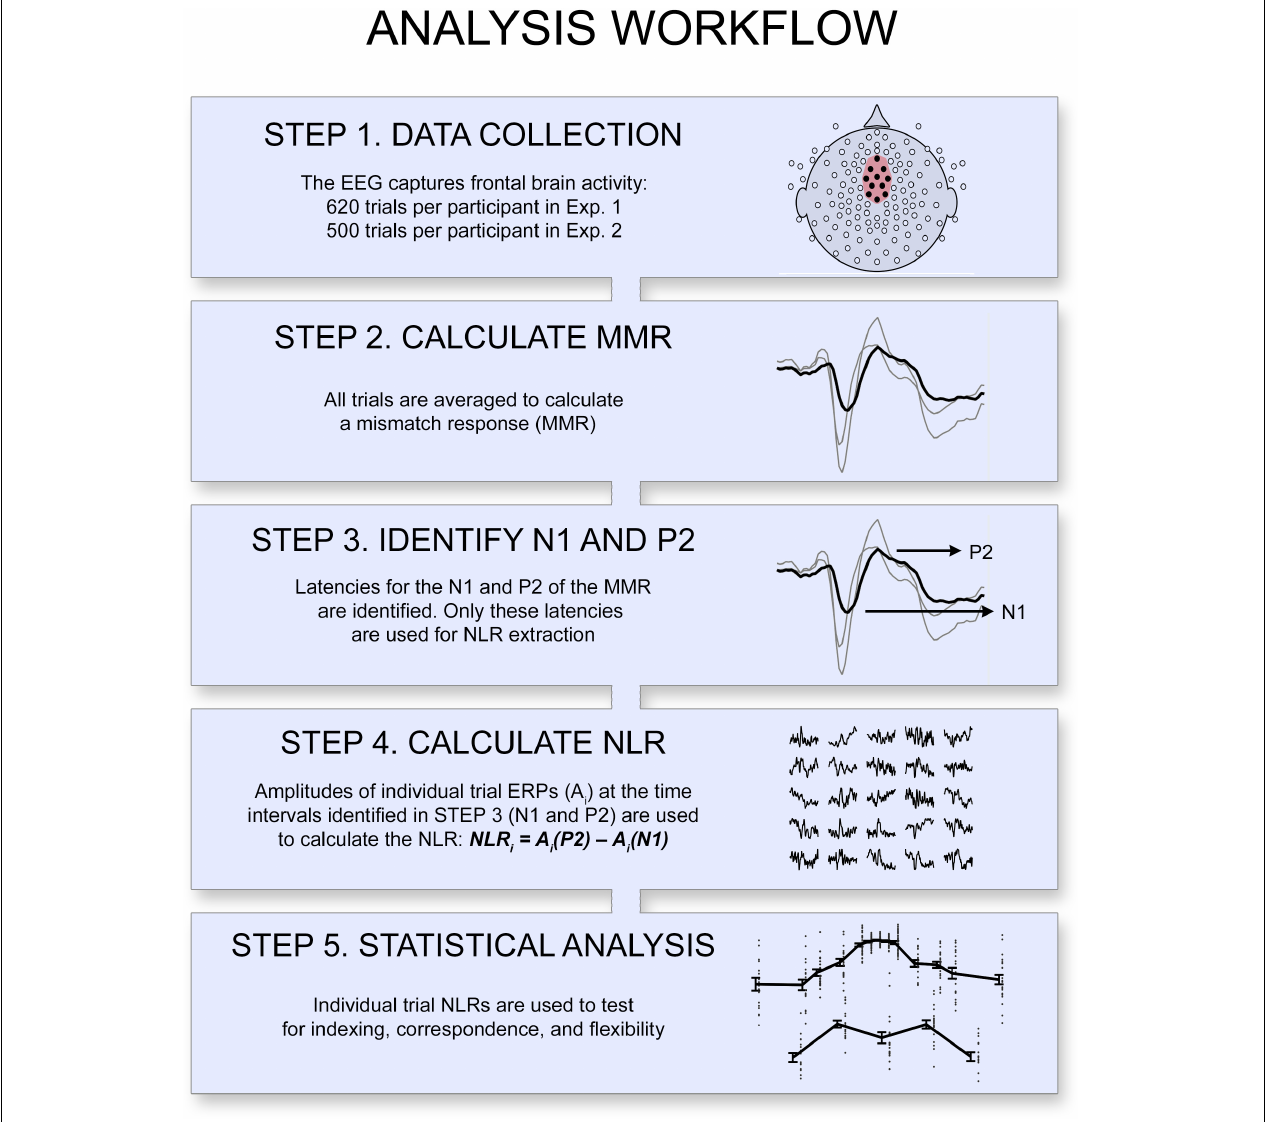
FIGURE 2 | Overview of the analysis workflow. A neural likelihood response (NLR) was calculated for each item as the single-trial ERP amplitude difference at the latencies of the mismatch response’s positive peak (P2 MMR ) and negative peak (N1 MMR ). The statistical analyses tested the indexing-, correspondence-, and flexibility properties of the